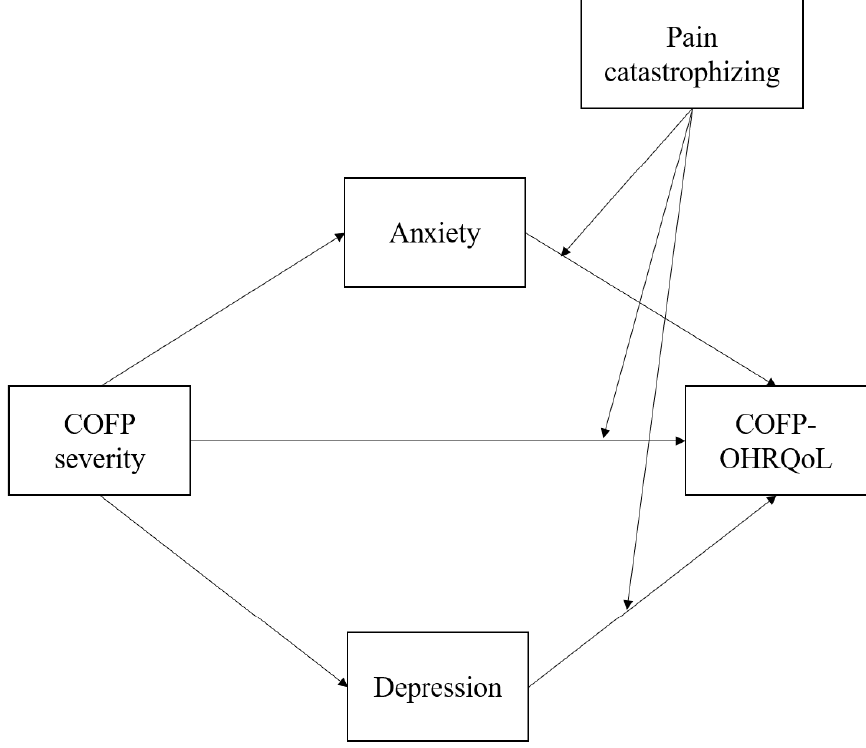
Figure 1. The theoretical moderated mediation model.